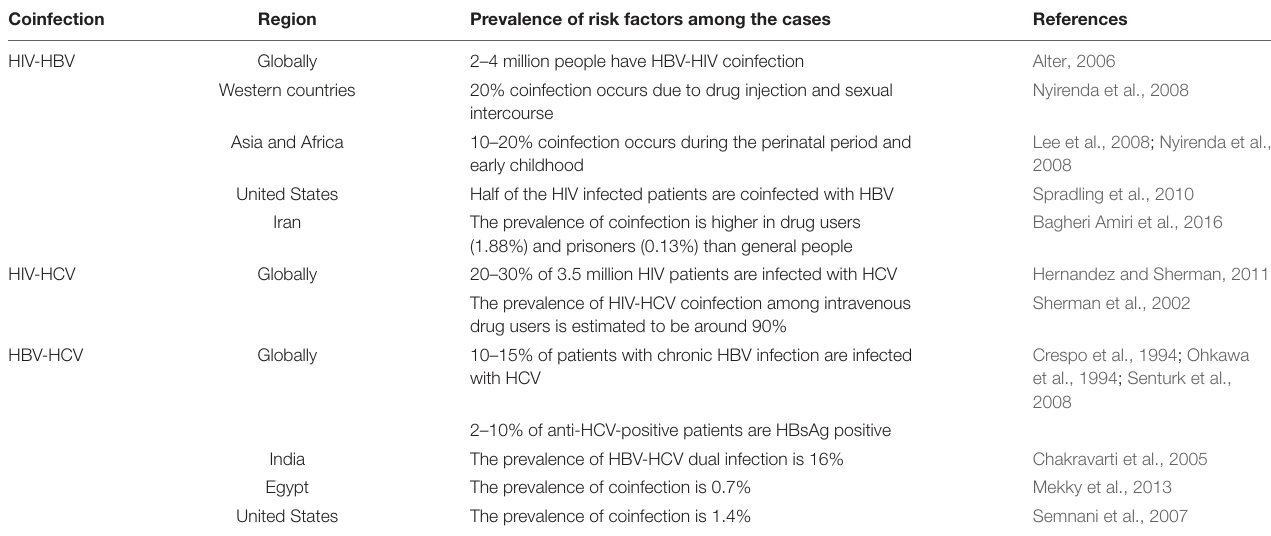
Coinfection Region Prevalence of risk factors among the